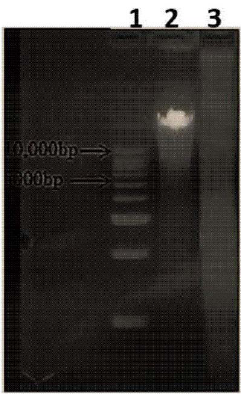
Fig. 1. Metagenome of Ulhas soil sample. Lane 1: 10 kb DNA ladder, 2: Metagenomic DNA (Ulhas); 3: Restricted digested with